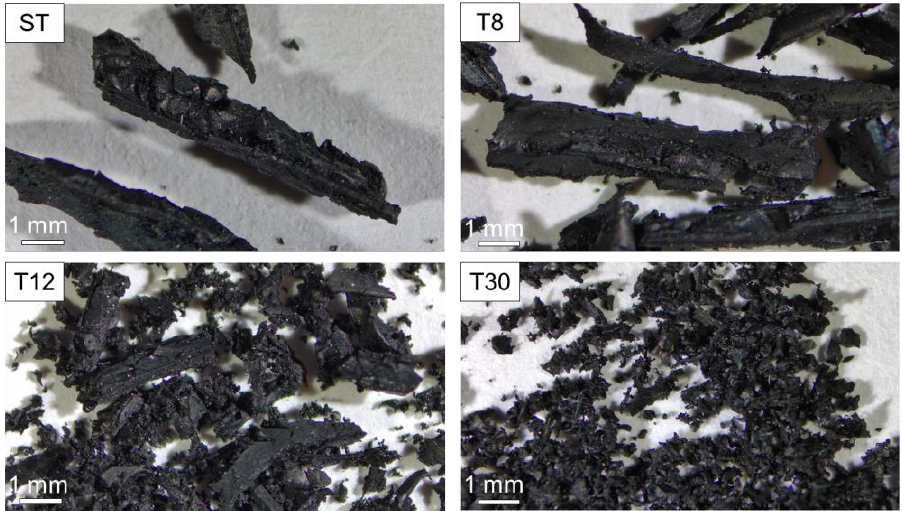
Figure 1. Images of recycled tyre rubber shreds (ST) and rubber crumbs (T8, T12 and T30) at different particle sizes. Table 1. Particle size analysis for recycled tyre crumbs T8, T12 and